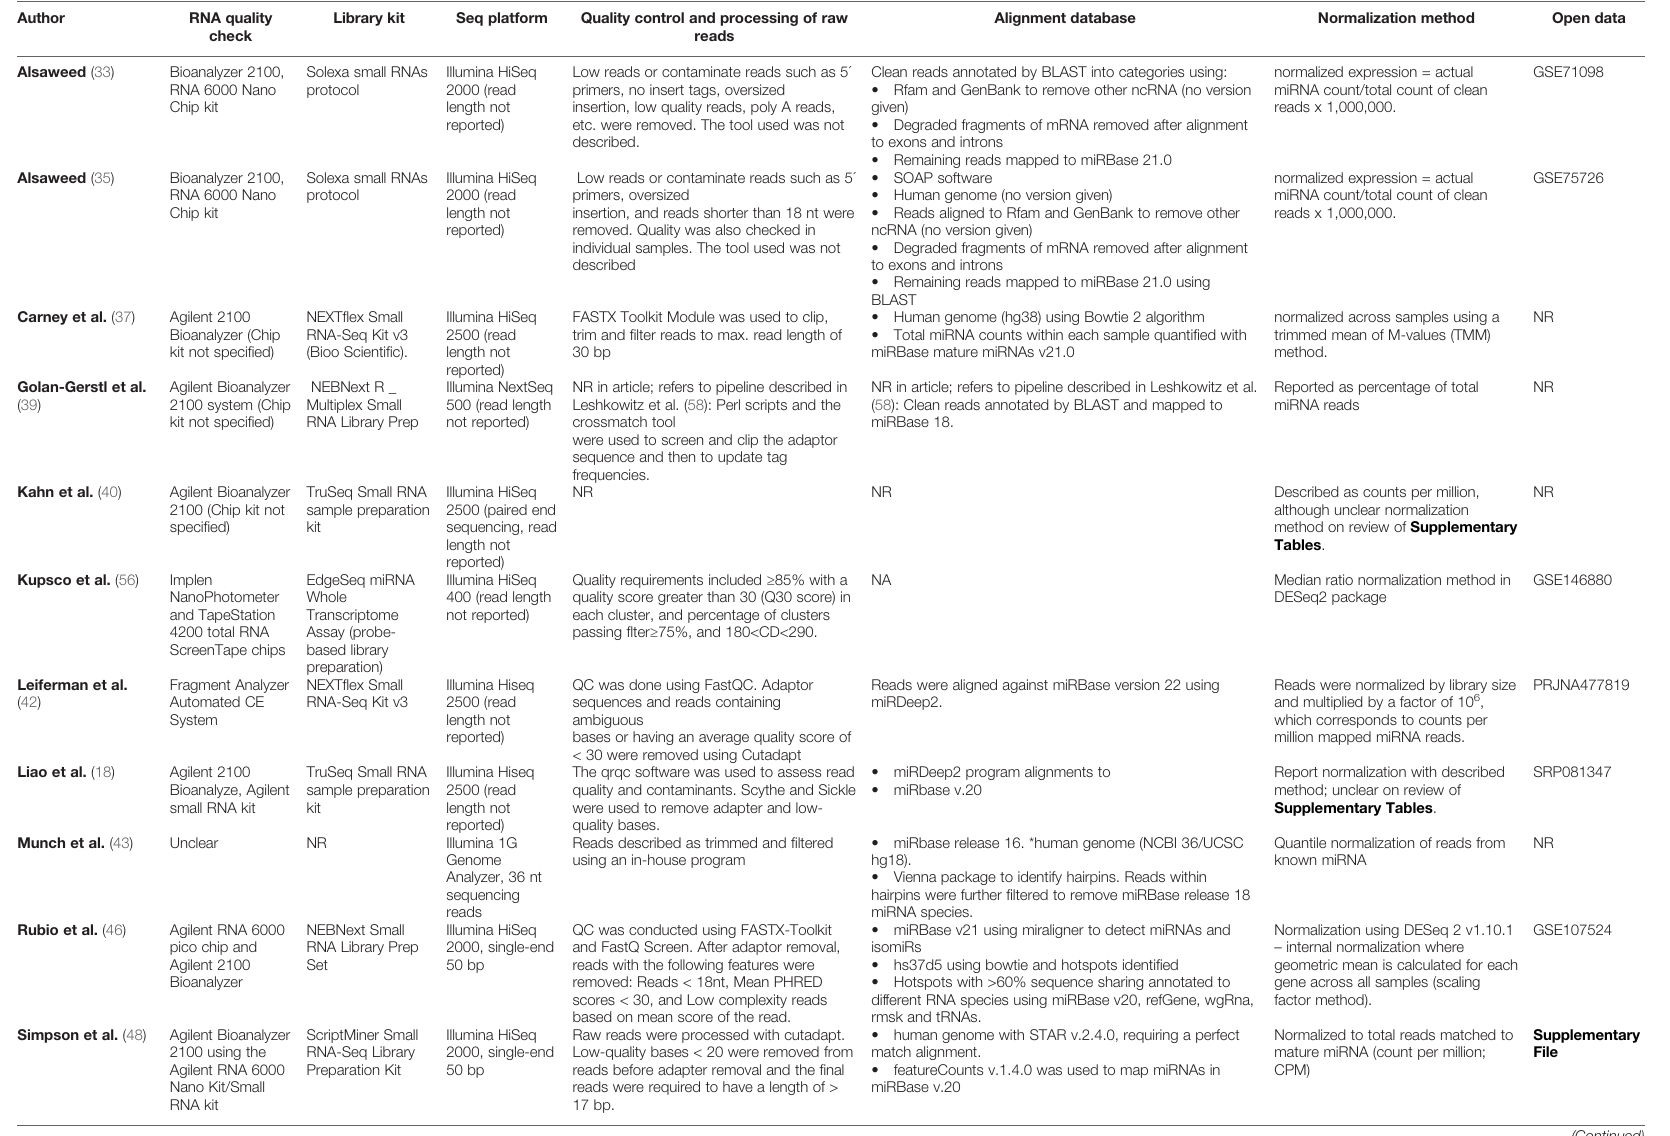
TABLE 3 | Methods of quanti fi cation in studies using RNA